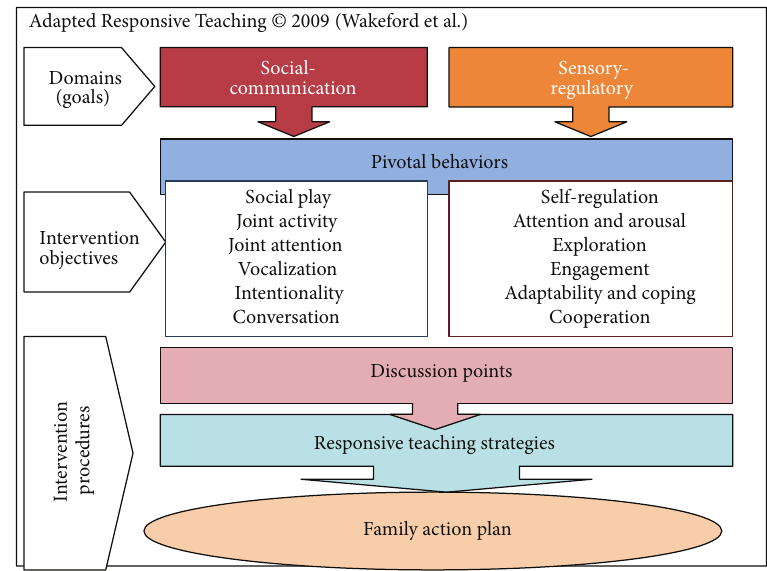
Figure 2: Adapted Responsive Teaching (ART) conceptual